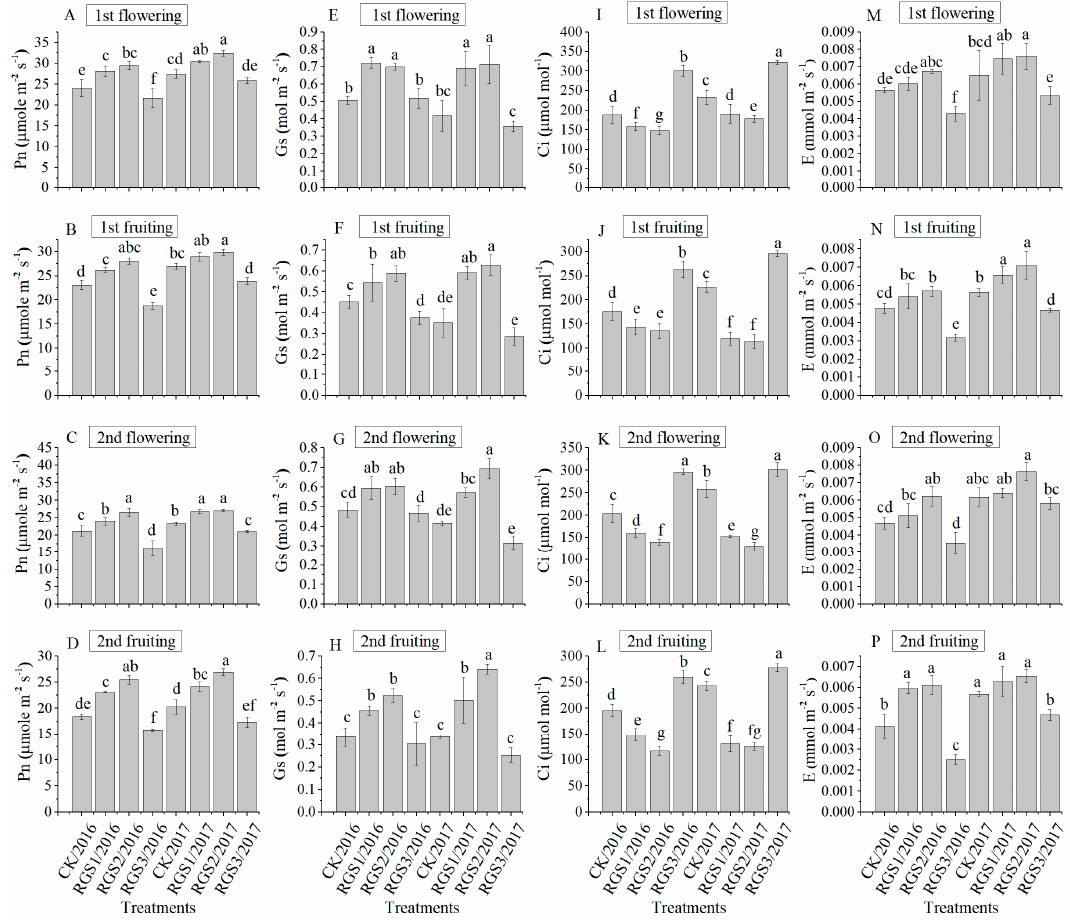
Figure 5. Effect of amendment with raw garlic stalk on different gas exchange parameters of eggplant. Net photosynthesis rate (Pn) ( A ) 1st flowering, ( B ) 1st fruiting, ( C ) 2nd flowering and ( D ) 2nd fruiting, stomatal conductance (Gs) during ( E ) 1st flowering, ( F ) 1st fruiting, ( G ) 2nd flowering and ( H ) 2nd fruiting, internal CO 2 (Ci) ( I ) 1st flowering, ( J ) 1st fruiting, ( K ) 2nd flowering and ( L ) 2nd fruiting, transpiration rate ( E ) ( M ) 1st flowering, ( N ) 1st fruiting, ( O ) 2nd flowering and ( P ) 2nd fruiting. The error bars represent standard error of the means ( n = 3). Different letters between treatments at different sampling stages show significant difference at p < 0.05 level (ANOVA and LSD).